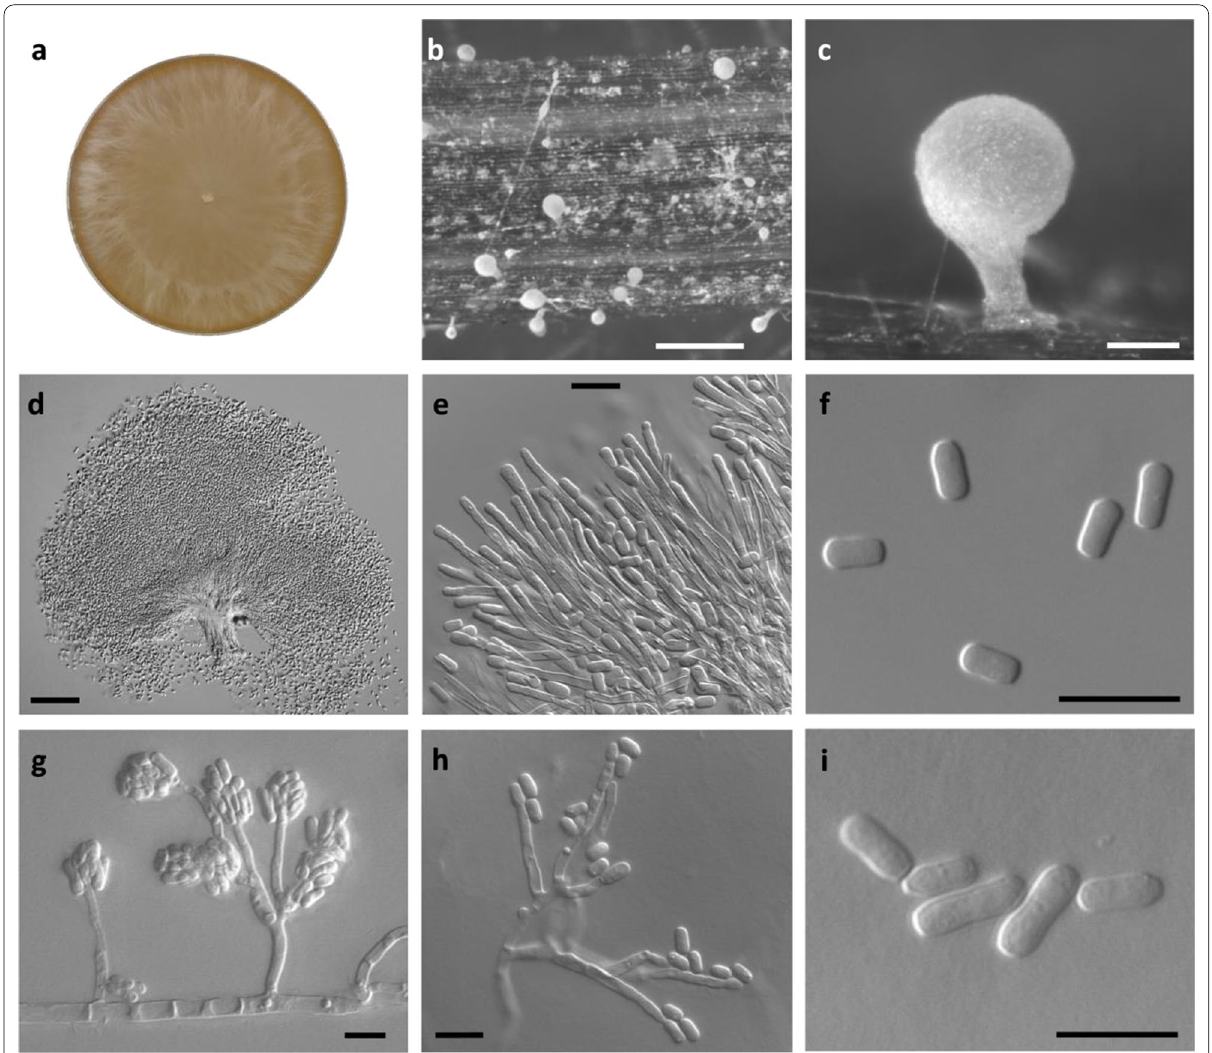
Fig. 9 Graphilbum ipis-grandicollis (VPRI43762). a Fourteen-d culture on MEA. b – d Pesotum-like macronematal asexual morph formed on pine needle mounted in WA. e – f Conidiogenous cells ( e ) and conidia ( f ) of Pesotum-like macronematal asexual morph. g. Hyalorhinocladiella-like asexual morph. h , i Conidiogenous cells ( h ) and conidia ( i ) of Hyalorhinocladiella-like asexual morph. Bars: b